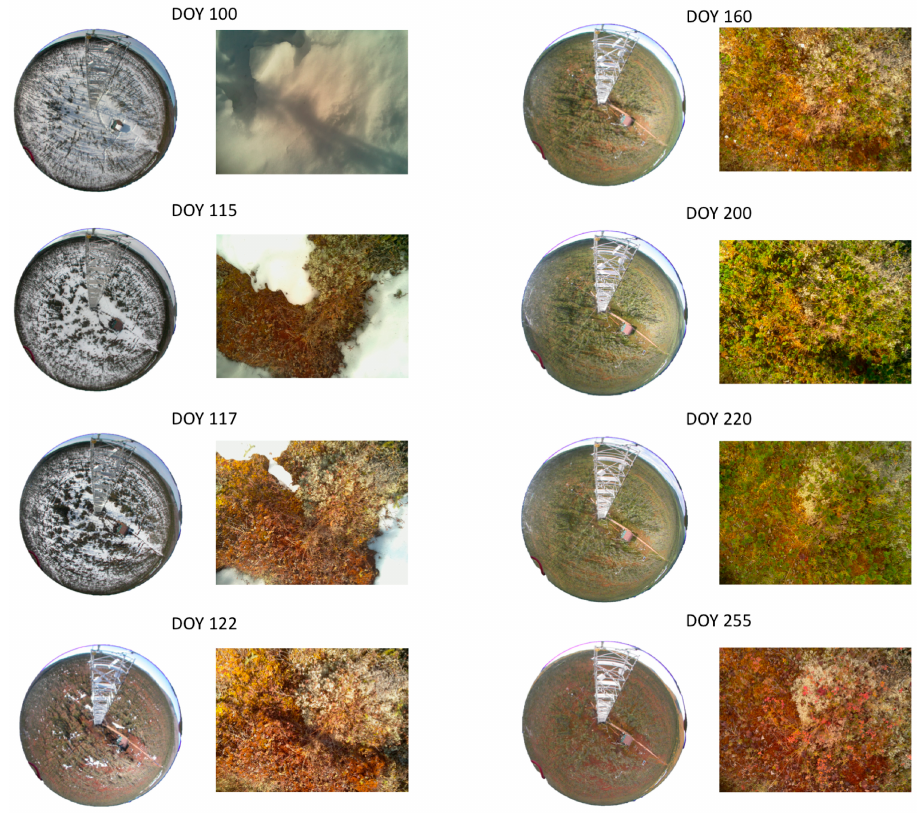
Figure A1. Time-lapse camera images obtained at the top of the tower and understory.